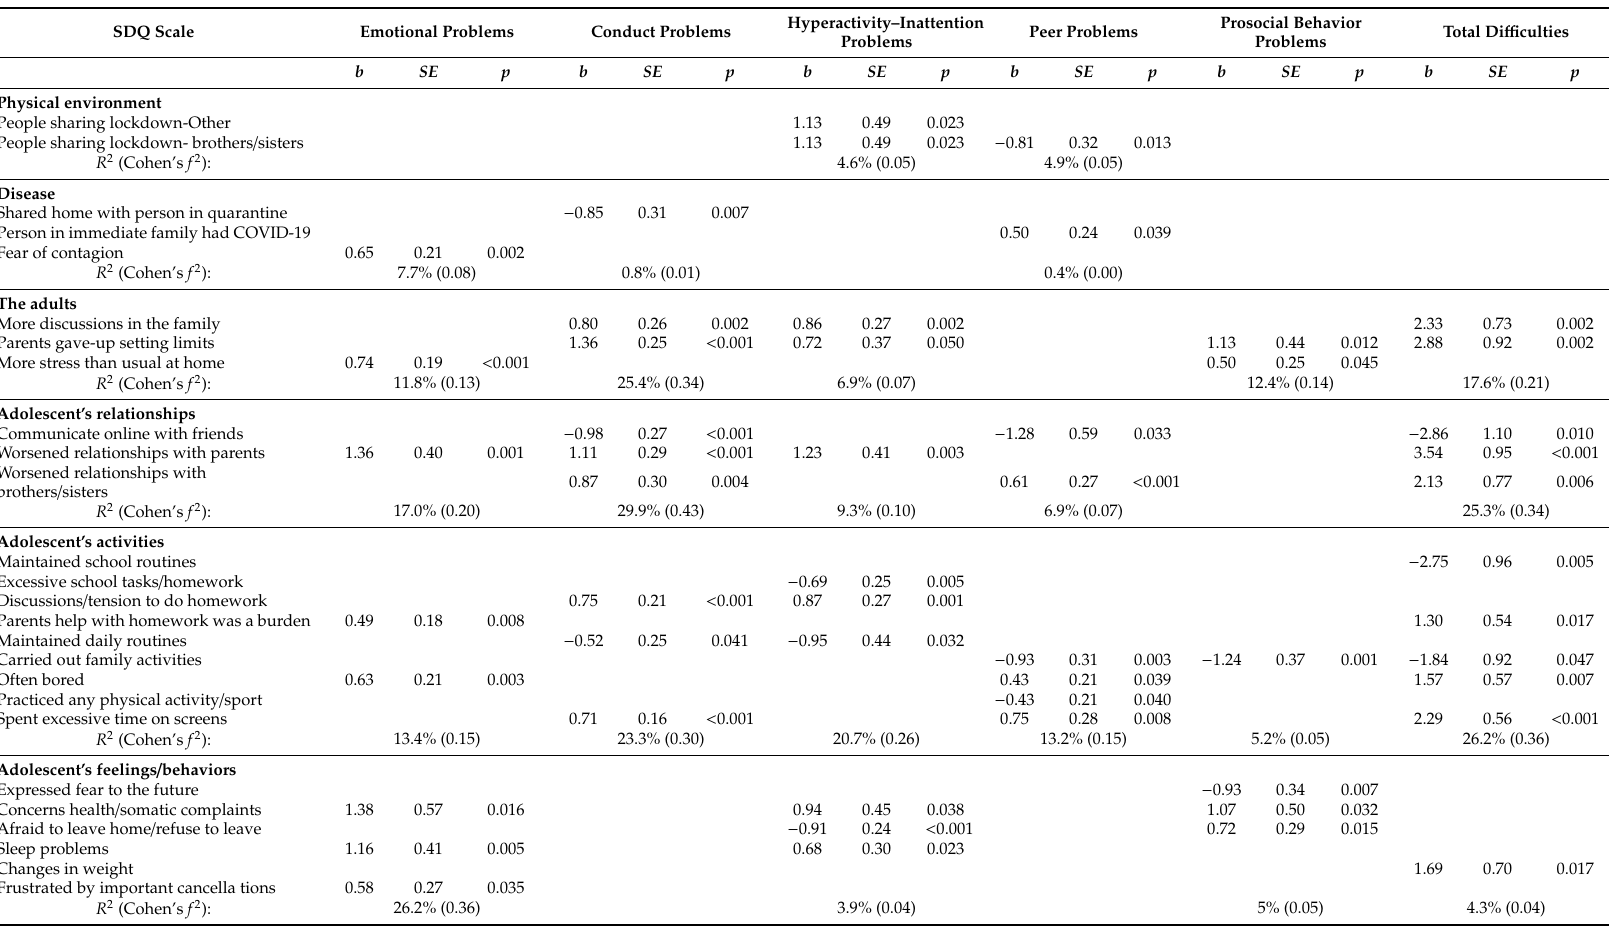
Table 2. Life condition predictors of post-COVID-19 psychopathology ( N =